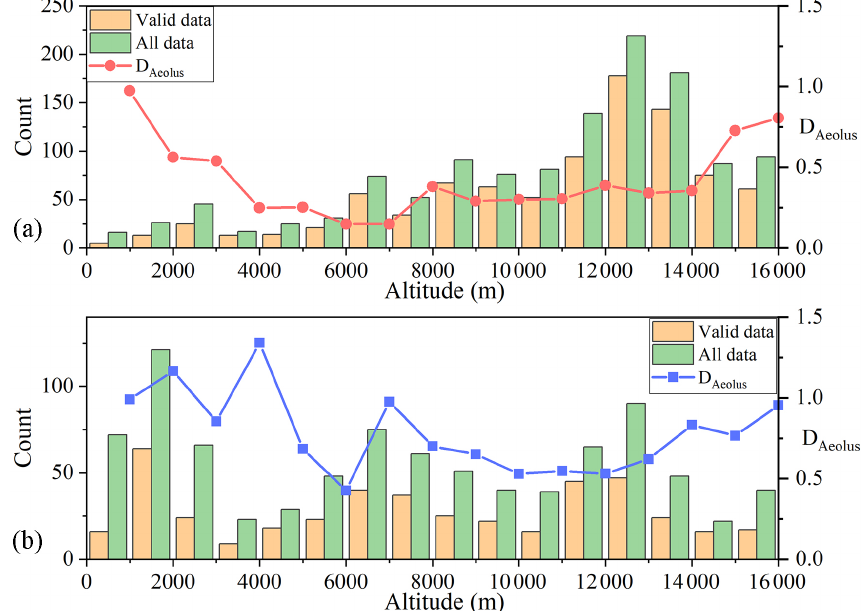
Figure 14. Distribution of Mie-cloudy data points and D Aeolus in altitude. (a) July 2020 and (b) August 2020. Data are from